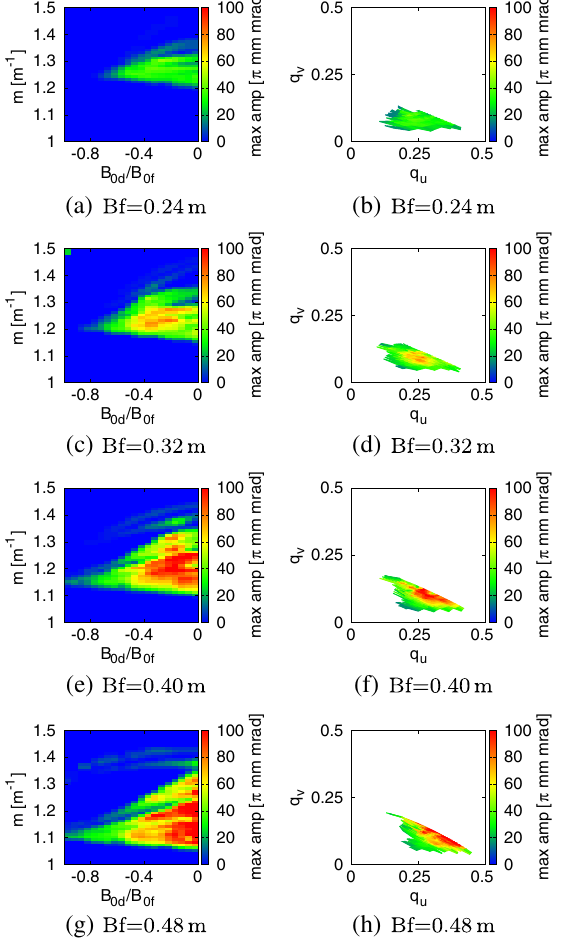
=B 0 space (a, c, e, g) and in d f